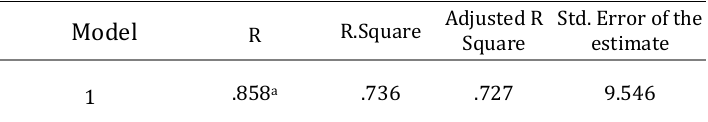
Table 2 Coefficient of